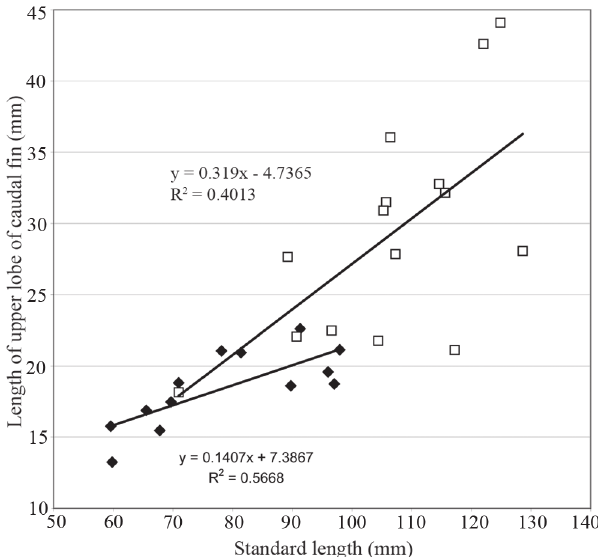
Fig. 7. Relationship between the standard length and the length of the upper lobe of the caudal fin in Pimelodella 2n = 46 (dark diamonds, N = 13) and 2n = 52 (light squares, N =